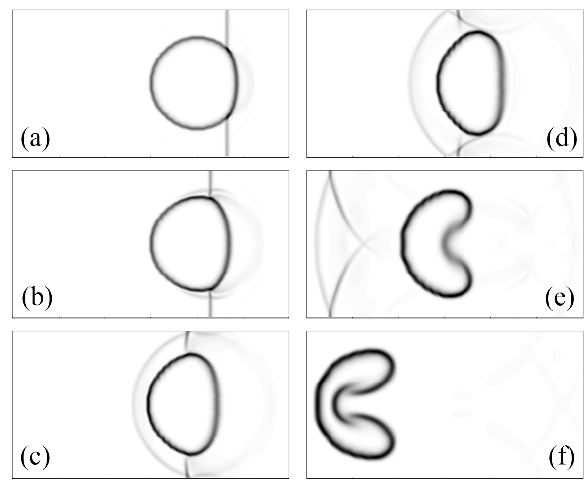
Figure 1. The schlieren-type images of density of the numerical results for shock bubble interaction (air-helium interaction). ( a ) t = 32 µs; ( b ) t = 52 µs; ( c ) t = 82 µs; ( d ) t = 105 µs; ( e ) t = 245 µs; ( f ) t = 427 µs.